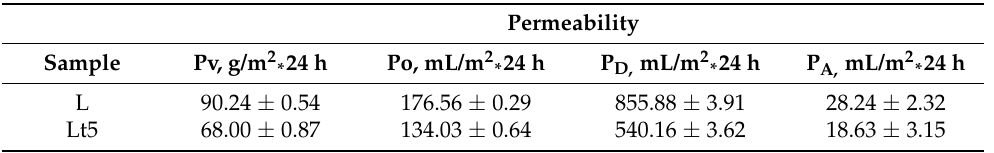
Table 1. Results of permeability of water vapor and gases through films without (L) and with birch tar